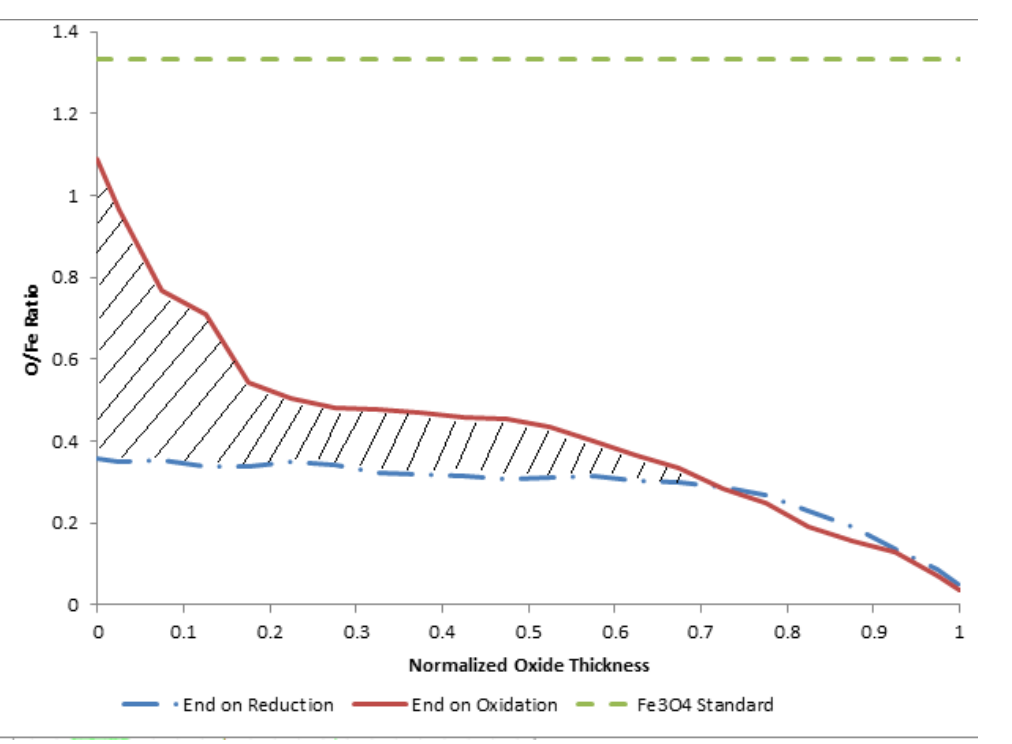
Figure 8. Comparison of relative oxygen content through the oxide layer for films terminated following reduction and films terminated following oxidation. The horizontal line represents the standard for Fe O . In the figure, 0 corresponds to the outer edge of the 3 4 oxide layer and 1 corresponds to the iron-iron oxide